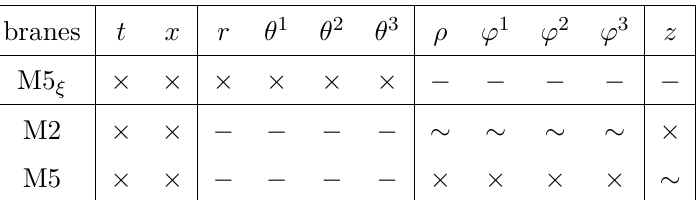
. The above system is 1 ξ 4